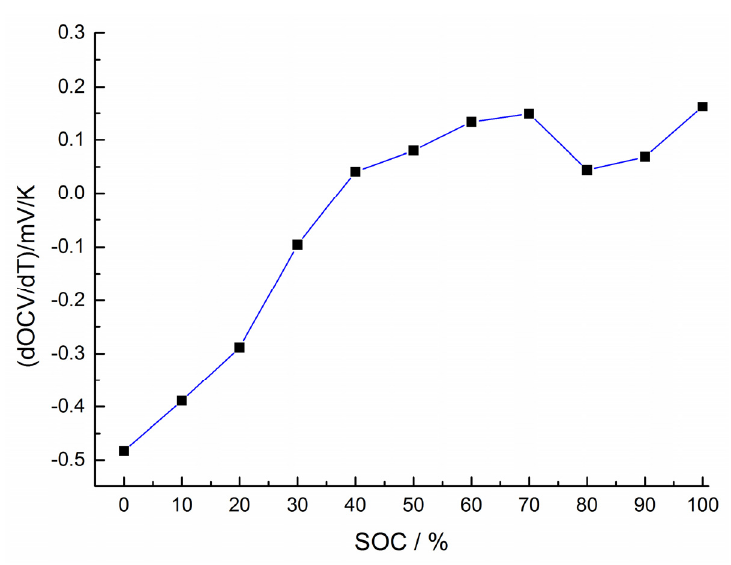
Figure 6. Entropy coefficient curve with the change of